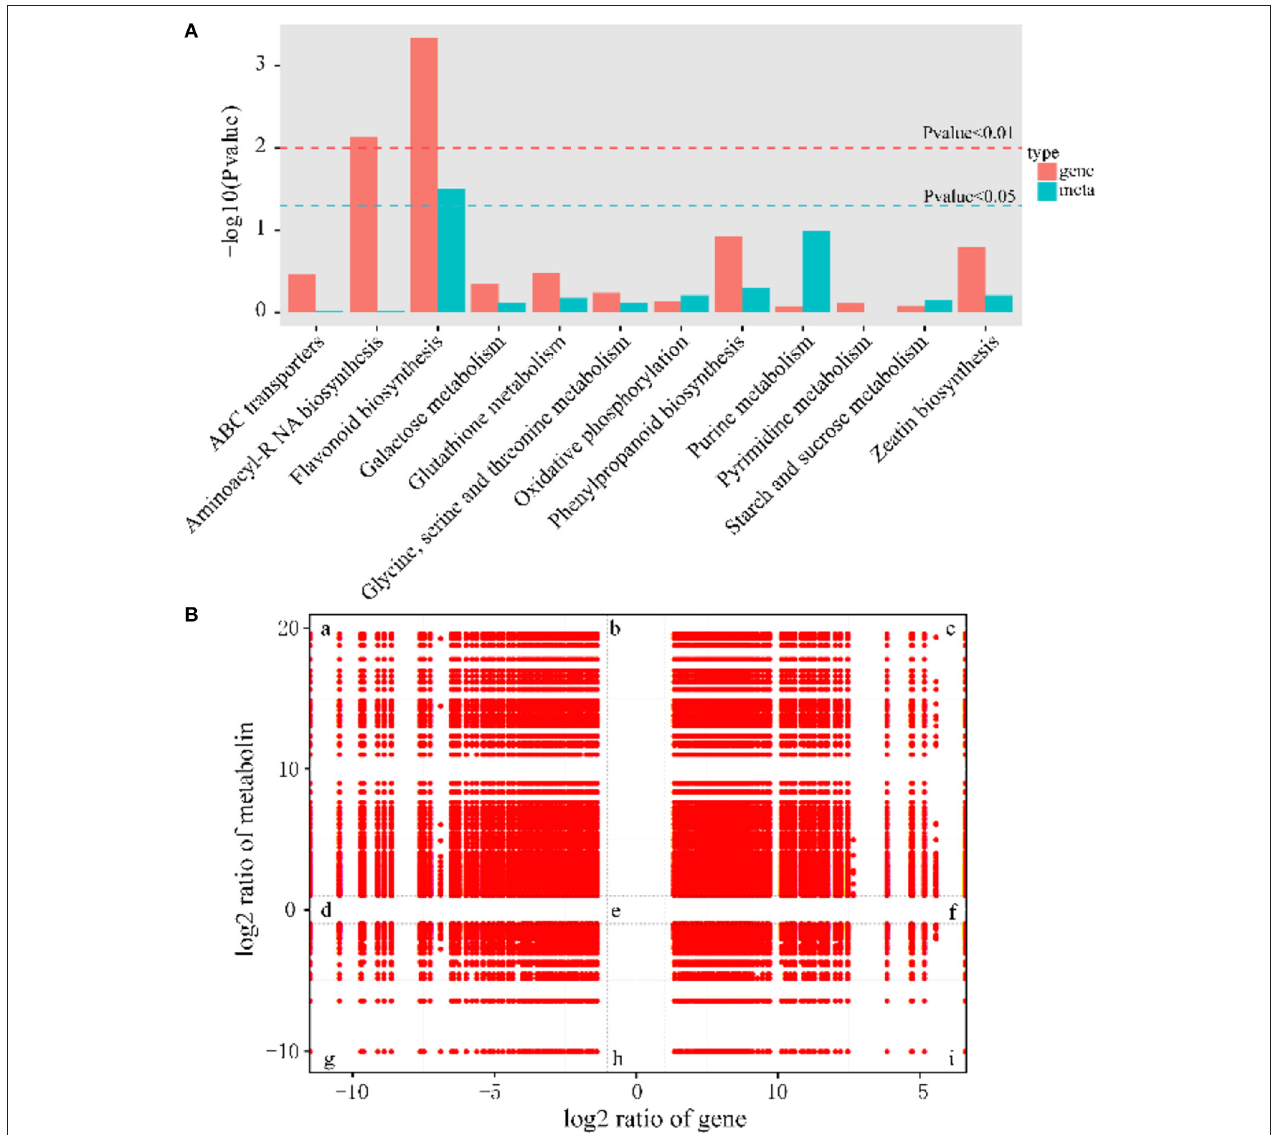
FIGURE 6 | Significantly related KEGG pathways and nine quadrant diagrams. (A) Integrated analysis of KEGG pathways of metabolome and transcriptome. (B) Nine squares indicated nine responsive groups: (a) Transcriptionally down-regulated and metabolically up-regulated genes. (b) Transcriptionally unchanged and metabolically up-regulated genes. (c) Transcriptionally and metabolically up-regulated genes. (d) Transcriptionally down-regulated and metabolically unchanged genes. (e) Transcriptionally and metabolically unchanged genes. (f) Transcriptionally up-regulated and metabolically unchanged genes. (g) Transcriptionally and metabolically down-regulated genes. (h) Transcriptionally unchanged and metabolically down-regulated genes. (i) Transcriptionally up-regulated and metabolically down-regulated genes. The X axis represents log2 expression ratios of gene and Y-axis represents log2 expression ratios of